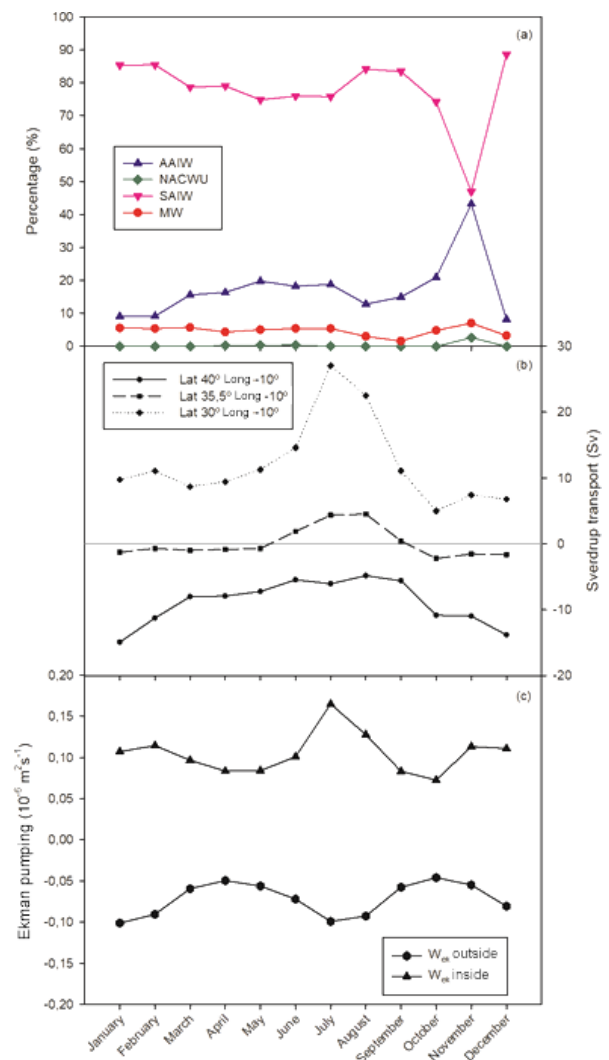
Figure 10. (a) Averaged percentages of each water mass resulting from the application of OMP analysis on WOA data, for each cli- matological month, at 35.5 ◦ N in the GoC. (b) Sverdrup transport at three locations close to the continental borders: south of GoC (30 ◦ N, 10 ◦ W), in the GoC (35.5 ◦ N, 10 ◦ W) and north of GoC (40 ◦ N, 10 ◦ W). (c) Monthly Ekman pumping in two zones: outside the GoC (between 35–36 ◦ N and 19–20 ◦ W) and inside the GoC (between 35–36 ◦ N and 7–8 ◦